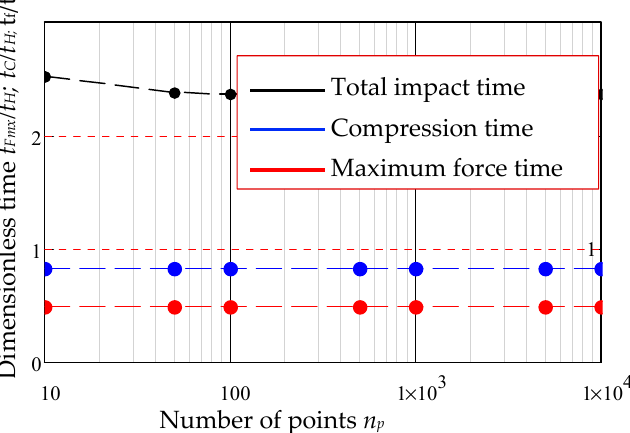
Figure 10. The effect of interval of velocity discretization upon precision of estimation for characteristic times.